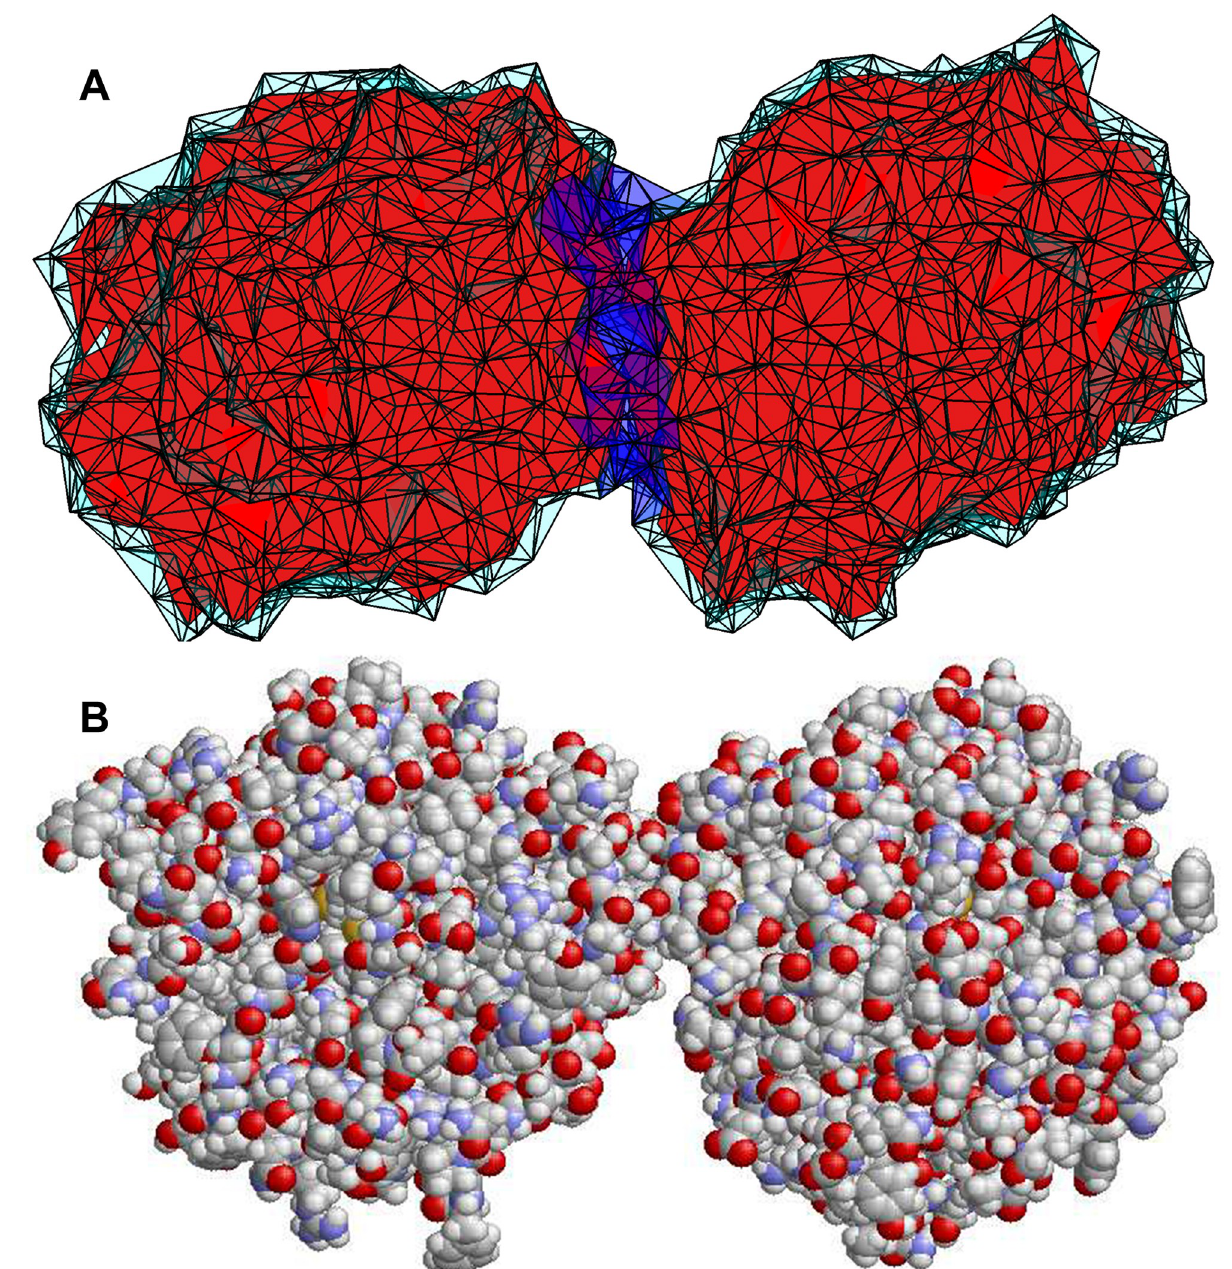
Fig 3. Models of a quaternary structure. (A) An elastic solid model of a quaternary structure (2pwa2.pdb). The pdb quaternary structure is available at https://github.com/gsongISU/sigmaESMrelease, under folder pdbDataset . (B) the all-atomic molecular model of the same structure. The image is generated by Rasmol